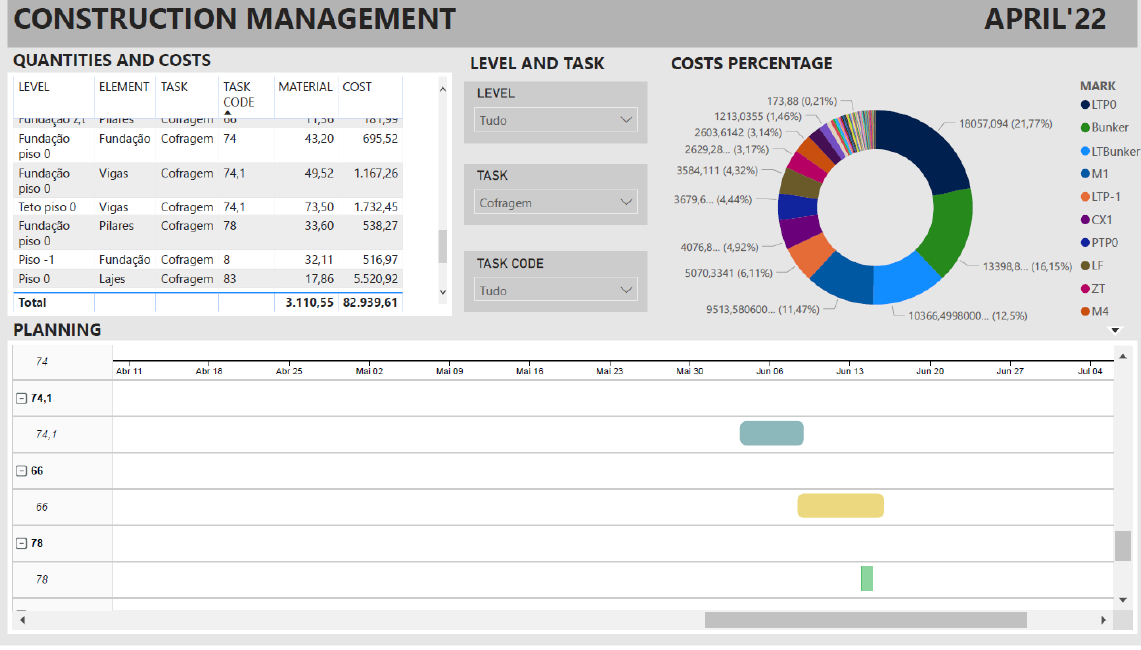
Figure 10. Power BI dashboards—Formwork tasks.